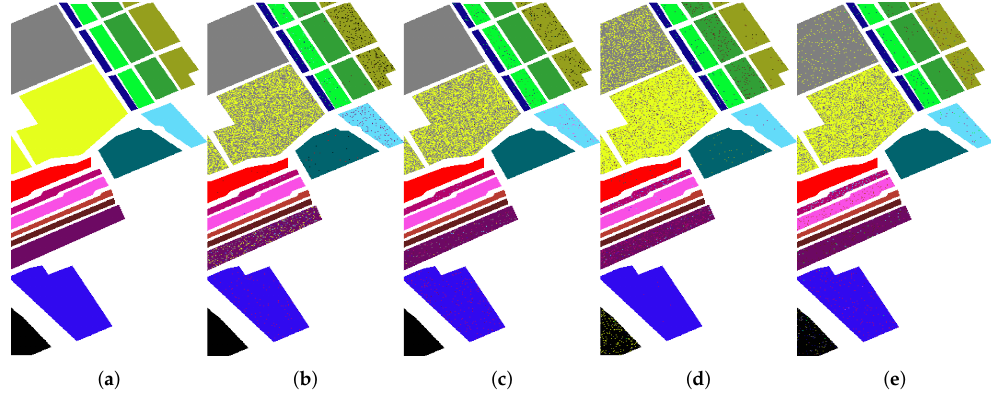
Figure 10. Salinas. Classification maps of different models. ( a ) Pseudocolor images; ( b ) Model-1; ( c ) Model-2; ( d ) Model-3; ( e )